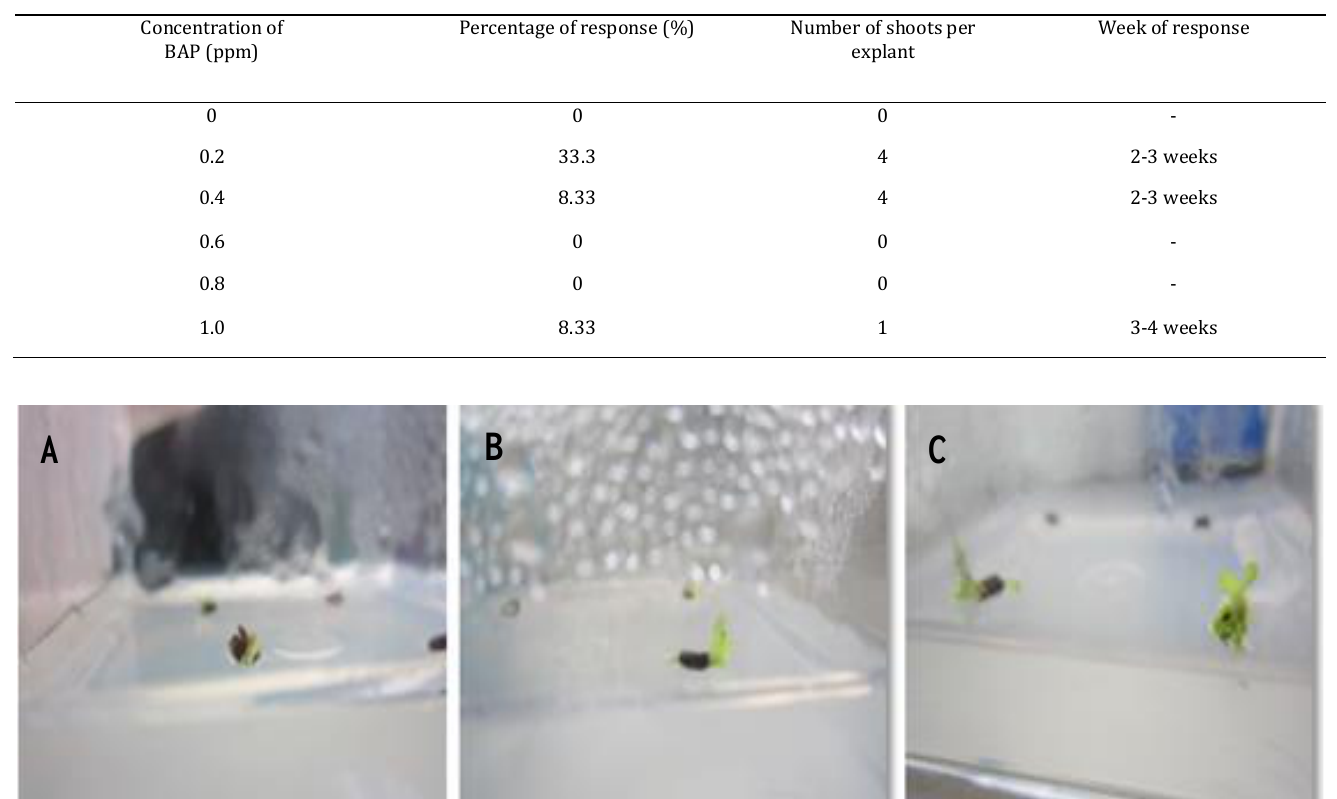
Figure 1: Shoot induction from axillary bud of O. stamineus medium with 0.2 ppm BAP after: A) 1 week of culture; B) 2 weeks of culture and C) 3 weeks of